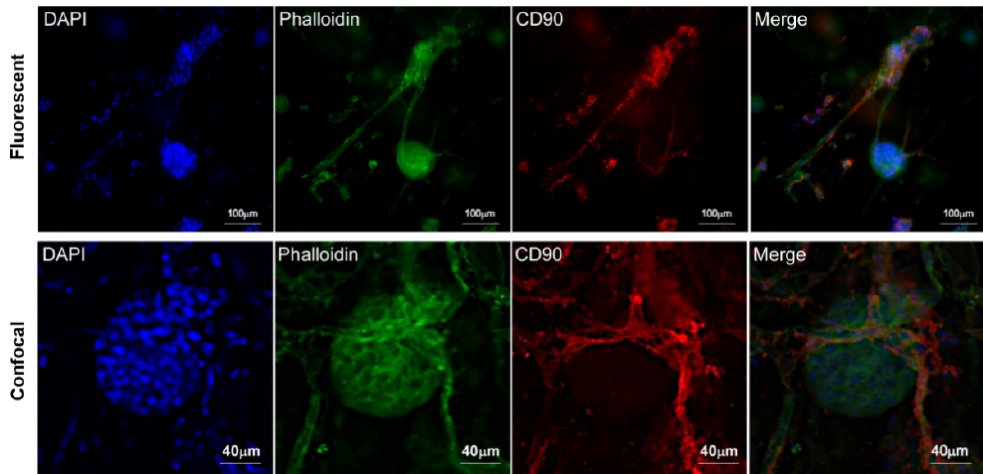
Figure 9. Fluorescence and confocal microscopy images of islet vascularized by ad-MVFs after coculturing in 3D collagen hydrogel at day 8. CD90 expression is localized on ad-MVF cells’ surface. Blue: DAPI; green: phalloidin-FITC; red: CD90.